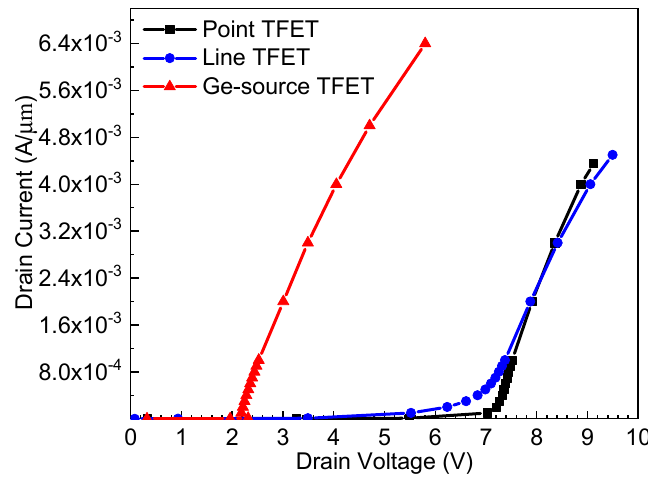
Figure 6. Simulated very fast TLP (VFTLP) curves of different TFETs.